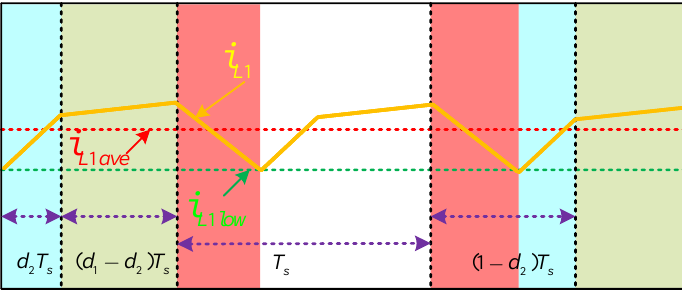
Figure 5. The waveform of i L 1